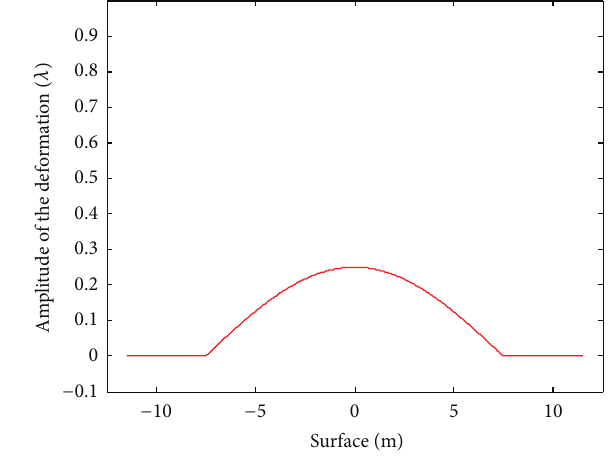
Figure 5: Example of deformation.